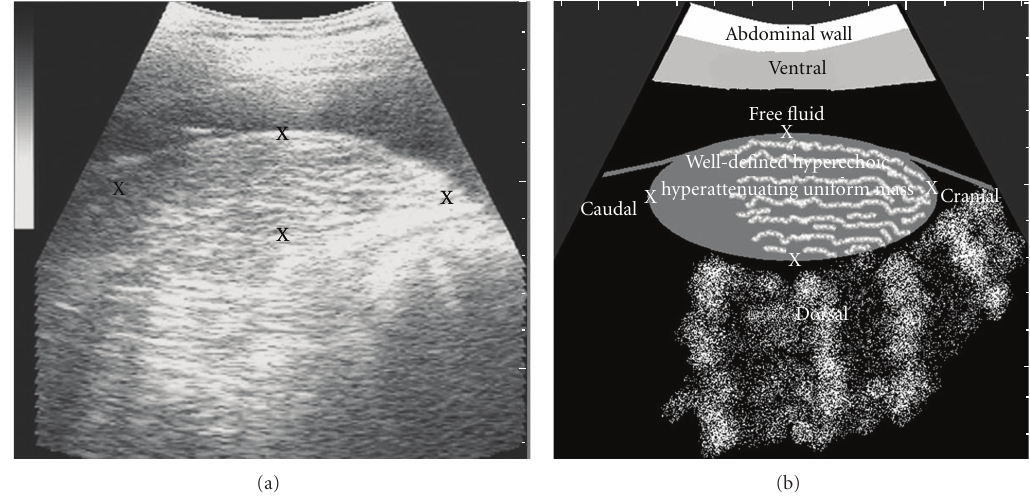
Figure 2: Ventral abdominal sonogram (cranial to navicular region) and its schematic depiction of a well-di ff erentiated hyperechoic hyperattenuating uniform mass with infiltrating echogenicity and hypoechogenic fluid surrounding it.